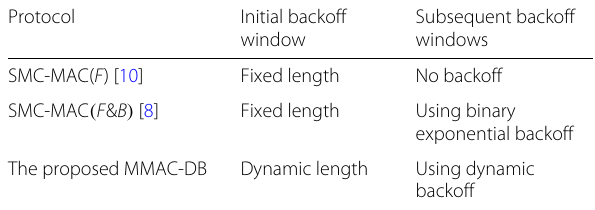
Table 2 Summary on the compared